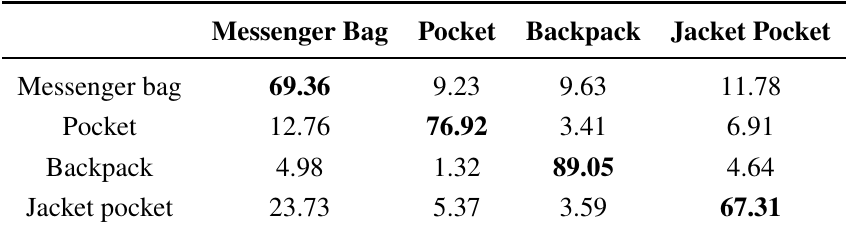
Table 5. Confusion matrices with all features, Dataset 1 (random forest).